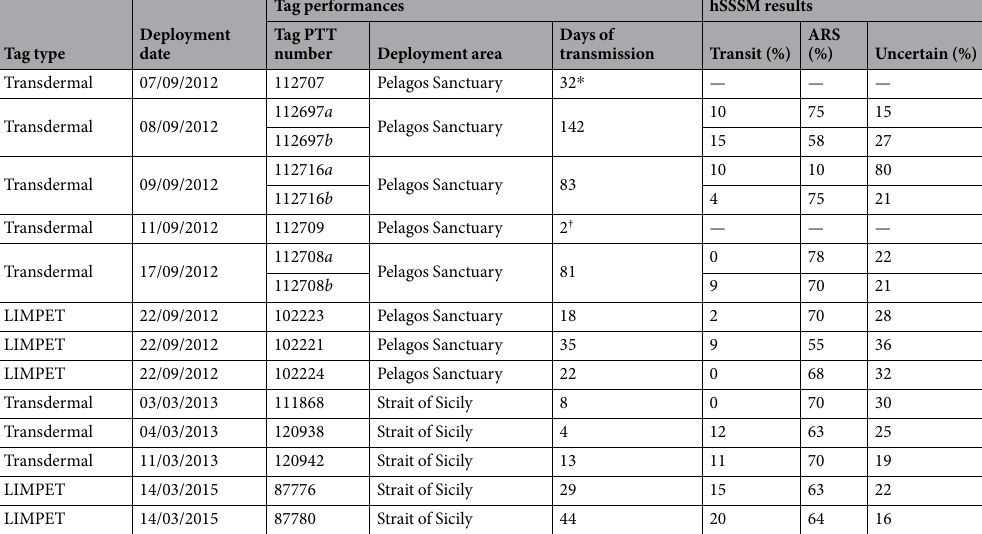
between the two behaviours or to short periods of directed movement within longer ARS intervals 62 , but these sources of uncertainty are confounded 63 .